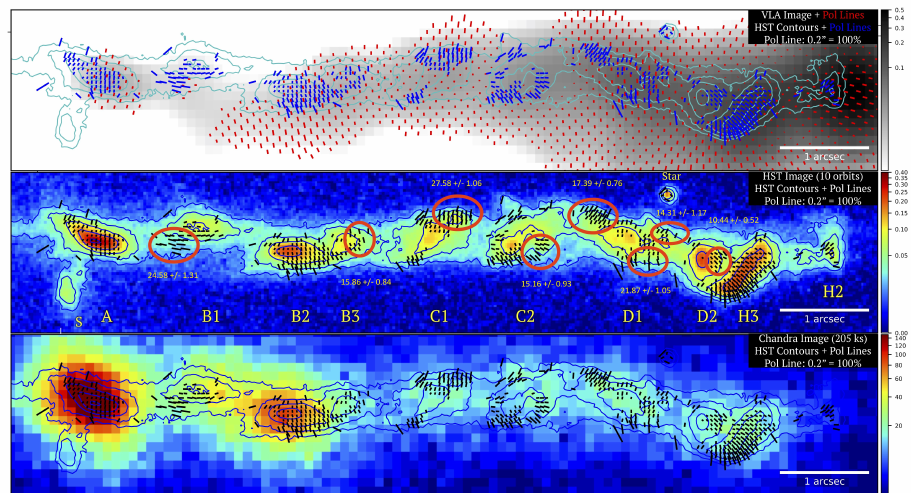
Figure 3. Top: VLA 8.4 GHz radio image of the 3C 273 jet (grayscale, scale at right) with radio polarization E-field vectors (in red) and new HST /ACS optical Stokes I contours (cyan) + optical polarization vectors (in blue). Optical contours increase by factors of two. Middle: Stokes I image using new HST /ACS + F606W data (in color, scale at right) with blue contours and black polarization E-field vectors overlaid. Jet components are labeled, and we have circled eight regions that are either at the jet edges or in between knots where the fractional polarization has been measured to be at least as high as that at knot maxima. Bottom: Chandra X-ray flux image (in color, scale at right) with HST /ACS Stokes I contours overlaid (in blue) and optical polarization E-field vectors (in black). In all cases, a polarization vector is of scale 0.2 arcsec = 100% polarization. We have filtered polarization vectors by showing only pixels with optical polarization SNR > 3.5 and radio polarization SNR > 5.0. Note the strong differences between both optical and radio morphologies in total flux and polarization. The optical flux and morphology is correlated with the X-ray flux in some very interesting ways, as discussed in the text. The color scale for each panel is at the far